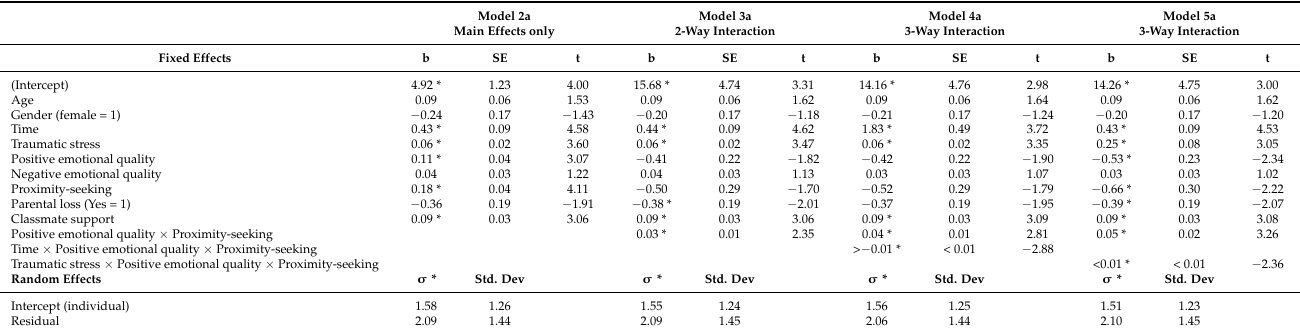
Table 4. Coefficients for factors affecting ethnic identity exploration ( n =